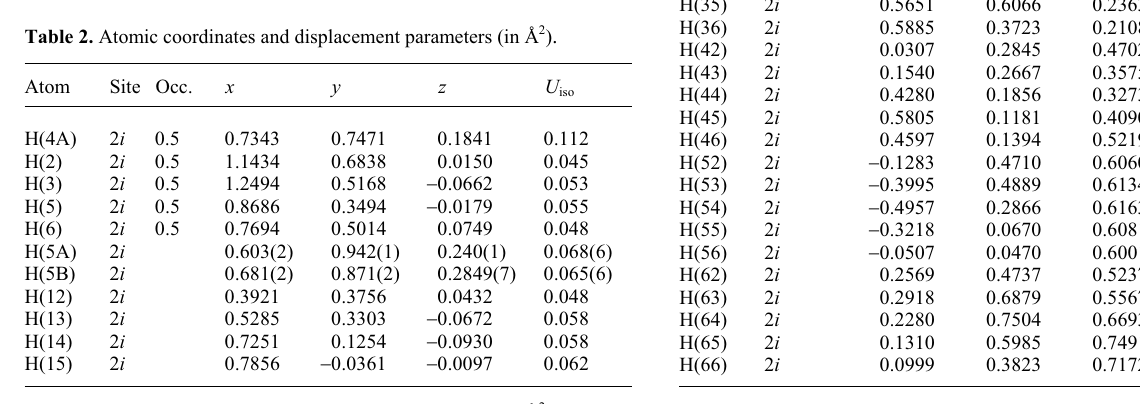
Table 3. Atomic coordinates and displacement parameters (in Å 2 )